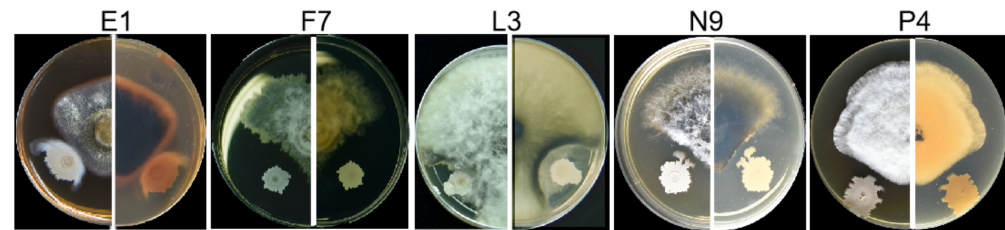
Figure 9. Inhibition e ff ects of Bacillus velezensis 3–10 on pathogens E1, F7, L3, N9 and P4. Mycelial plugs (5 mm in diameter) were punched out from the edge of the 5-day-old fungal culture and placed onto the center of PDA plates. Biocontrol bacteria were cultured in LB and were adjusted to OD 600 = 1.5, 1 µ L of which was spotted onto the plate 1.5 cm from the plate edge. All plates were incubated at 28 ◦ C until mycelia developed to the edge of the